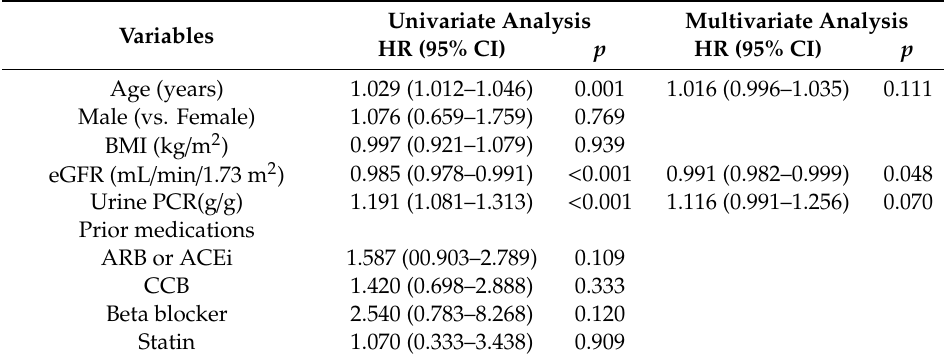
Table 4. Predictors of CKD progression in univariate and multivariate Cox regression analyses.